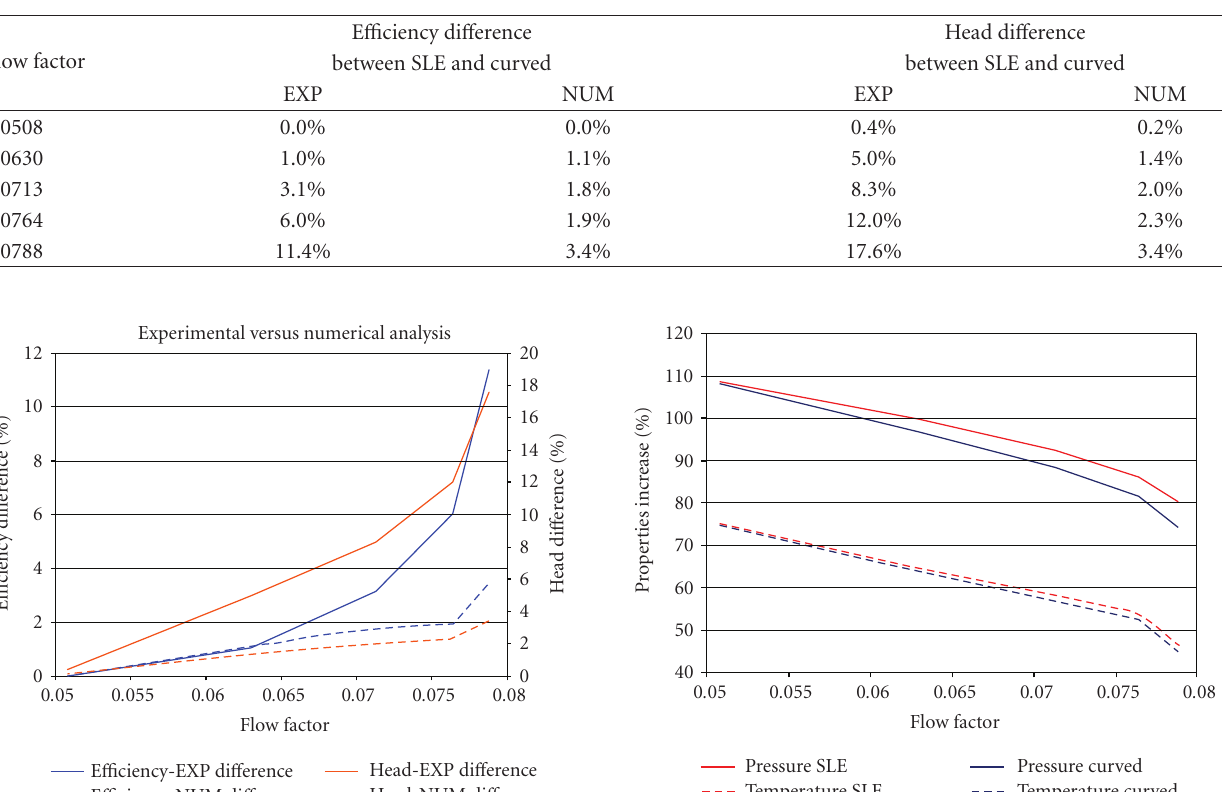
Table 1: Experimental and numerical comparative results.